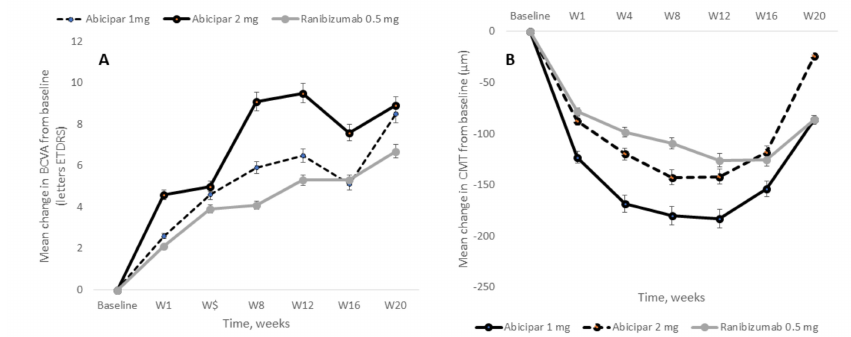
Figure 7. Mean changes in best corrected visual acuity (BCVA) ( A ) and central macular thickness (CMT) ( B ) from baseline in the modified intent-to-treat population of the REACH study. Adapted from Callanan et al.